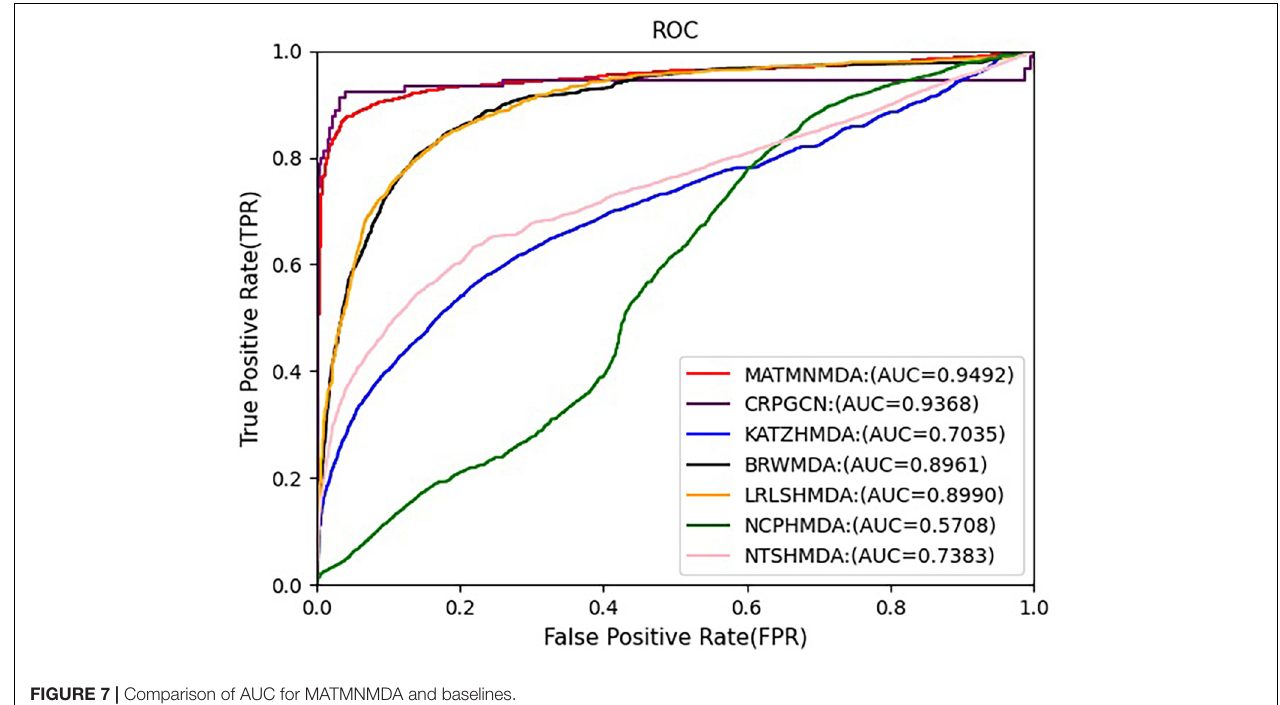
FIGURE 7 | Comparison of AUC for MATMNMDA and baselines.